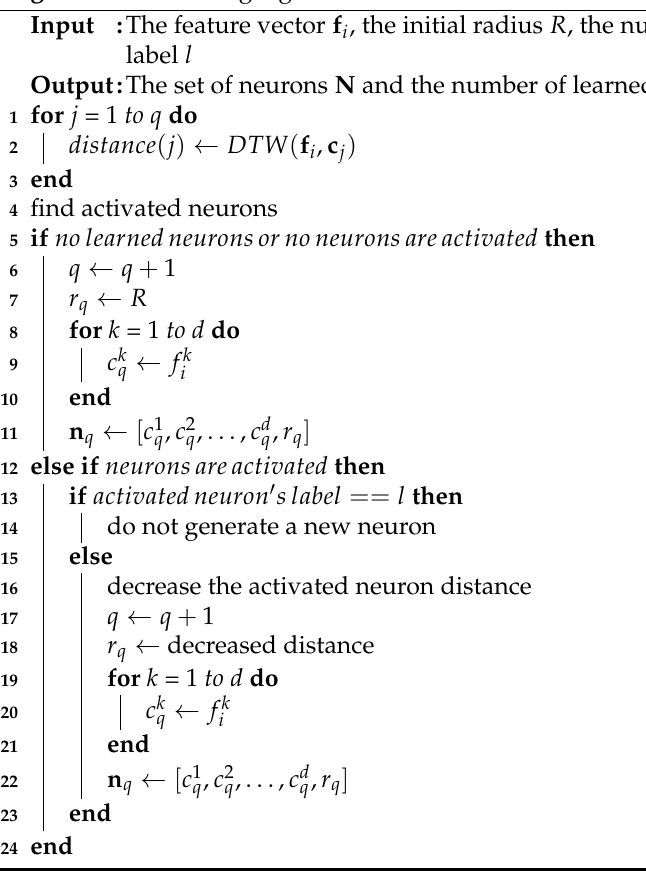
Algorithm 1: Learning algorithm.